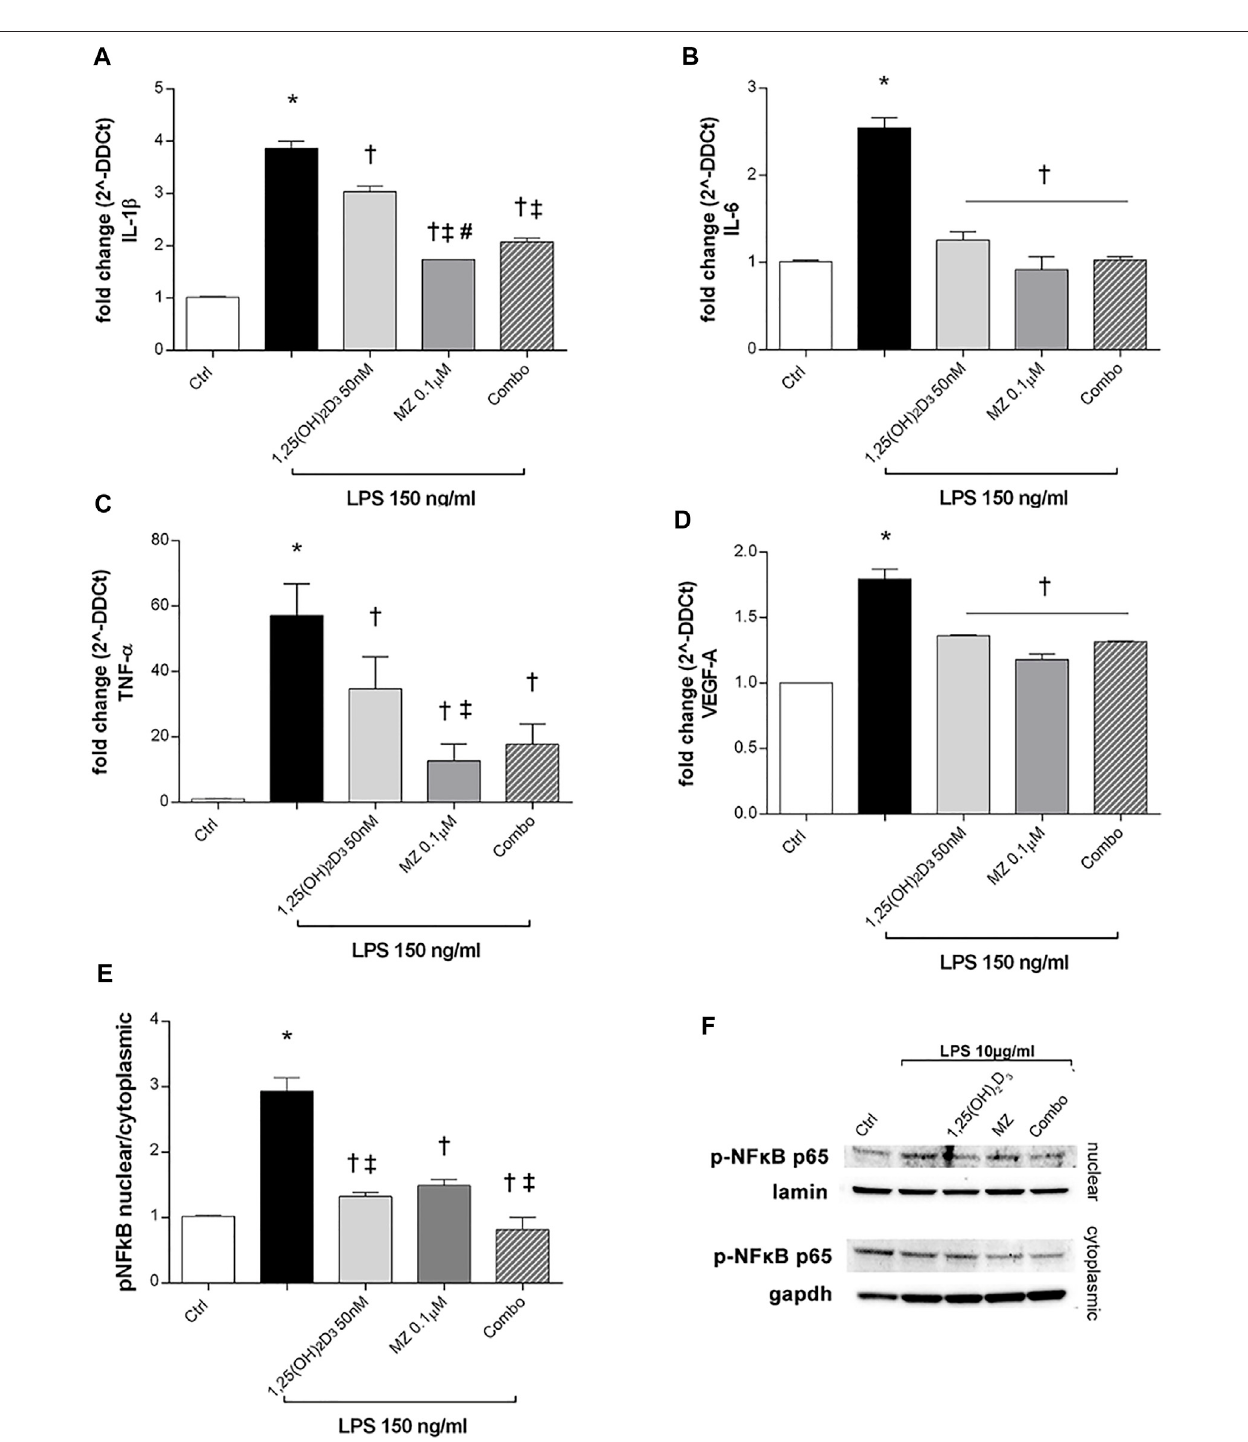
FIGURE 5 | 1,25(OH) 2 D 3 , meso-zeaxanthin (MZ), and their combination protect ARPE-19 cells from LPS-induced damage. 1,25(OH) 2 D 3 , meso-zeaxanthin (MZ), and their combo reduced IL-1 β (A) , IL-6 (B) , TNF- α (C) , and VEGF-A (D) mRNA expression. ARPE-19 cells were pretreated for 24 h with 1,25(OH) 2 D 3 (50 nM), MZ (0.1 µM), and their combo (1,25(OH) 2 D 3 50 nM + MZ 0.1 µM), and then challenged with LPS (150 ng/ml) for 2 h. The mRNA levels were evaluated by qPCR. (E) Densitometryof p -NF κ Bp65nucleartranslocationintreatedcells.ARPE-19cellswerepretreatedfor24 hwith1,25(OH) 2 D 3 (50 nM),MZ(0.1 µM),andtheircombo (1,25(OH) 2 D 3 50 nM + MZ 0.1 µM), and then challenged with LPS (10 μ g/ml) for 2 h. (F) Representative images of blots of nuclear and cytoplasmic protein. Each bar represents the mean value ± SD ( n (cid:2) 5; each run in triplicate). Data were analyzed by one-way ANOVA and Tukey ’ s post hoc test for multiple comparisons. * p < 0.05 vs. control; † p < 0.05 vs. LPS; ‡ p < 0.05 vs. 1,25(OH) 2 D 3 and MZ; # p < 0.05 vs. combo.